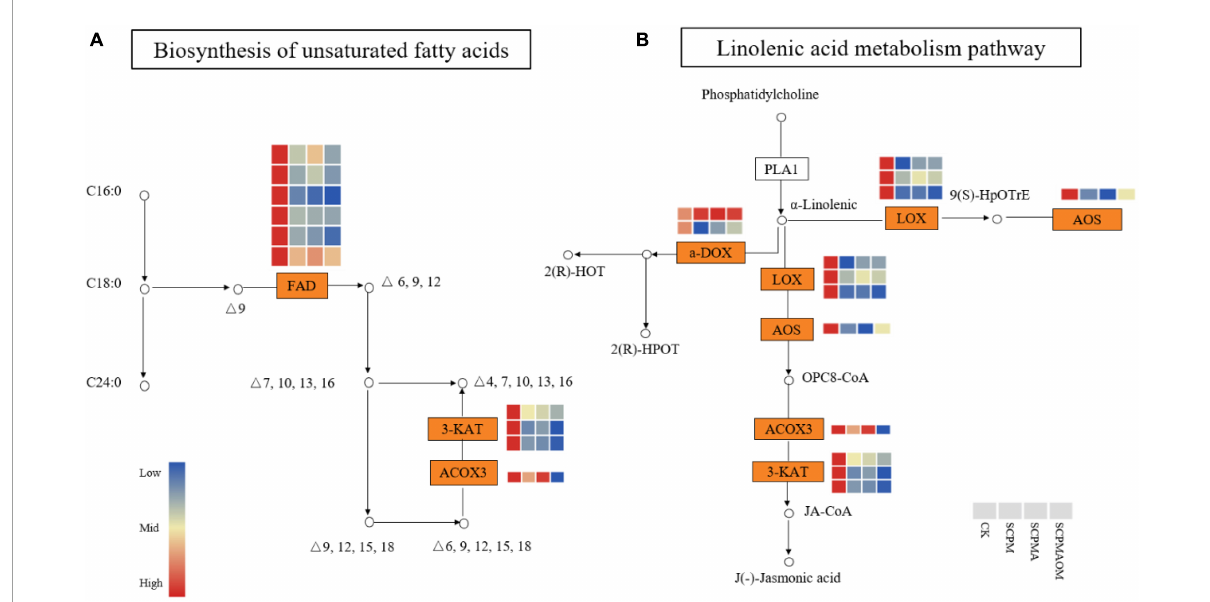
FIGURE7 The expression patterns of DEGs in the biosynthetic pathways of unsaturated fatty acid (A) and α -linolenic acid (B) . Red color denoted genes with high expression level, while blue color denoted genes with low expression level. The relative expression levels of DEGs were calculated using the log2